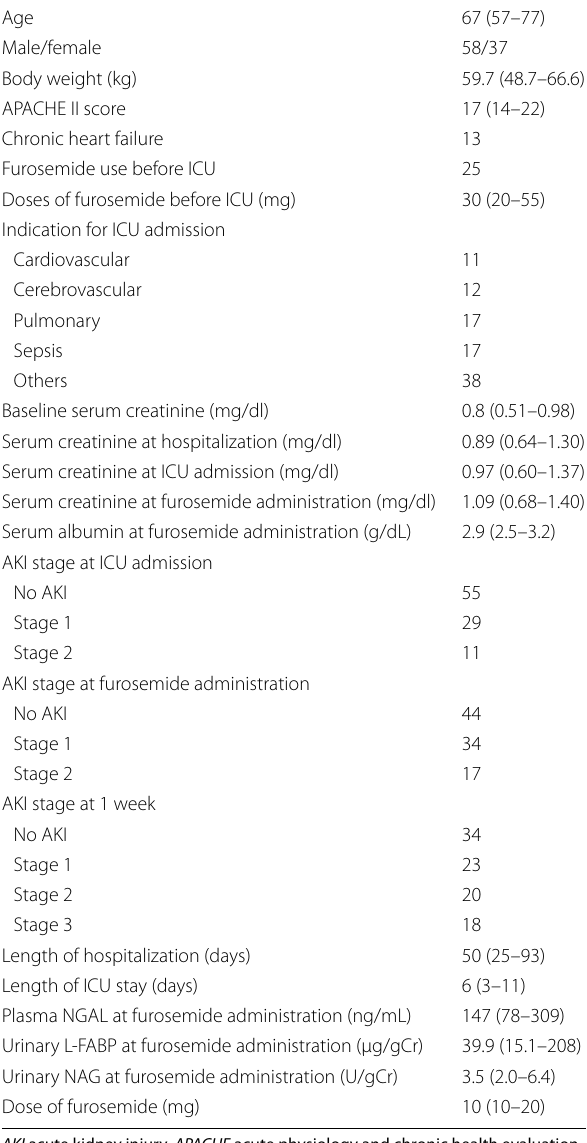
Table 1 Characteristics of the 95 enrolled